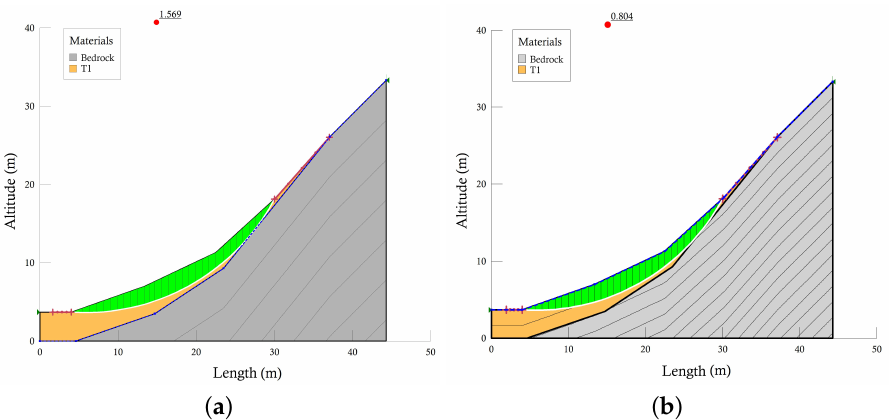
Figure 12. Deterministic analysis: Slope profile n.1: ( a ) no water and ( b ) piezometric line at the ground surface.